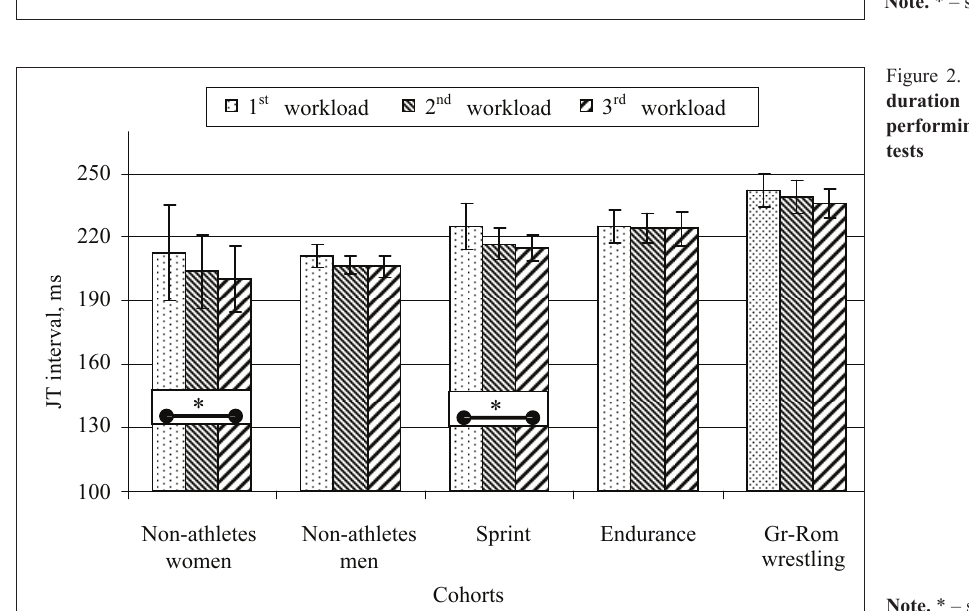
Figure 1. Value of HR registered at the end of workload while performing three Roufier